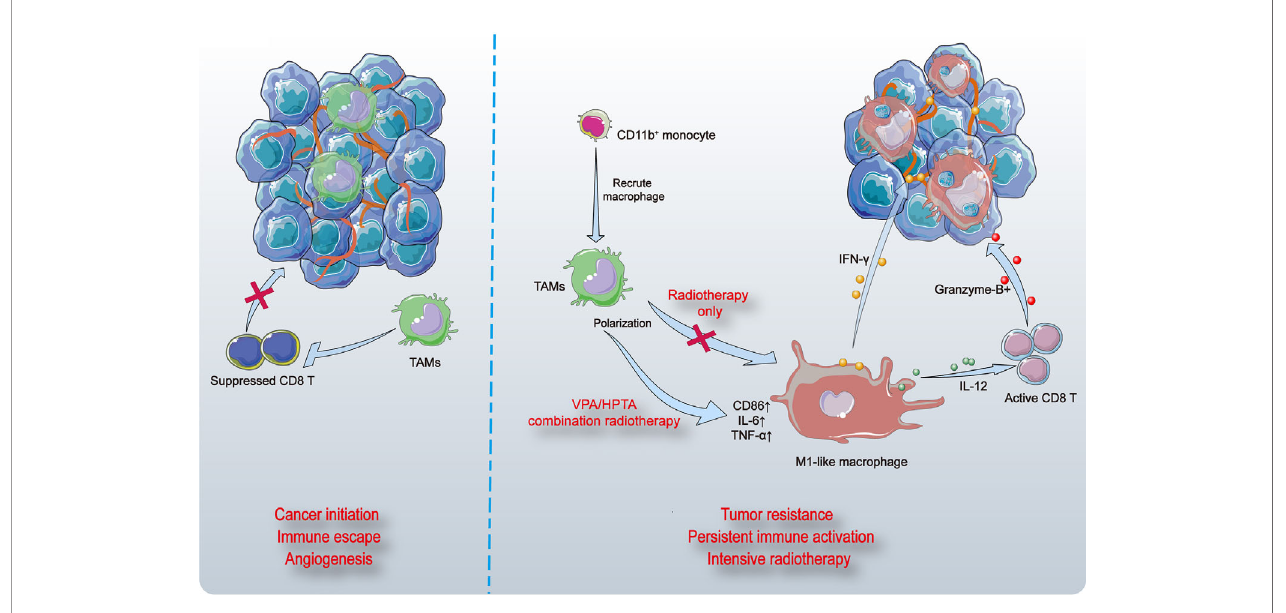
FIGURE 8 | The model of VPA/HPTA to enhance and prolong the radiotherapy effect by activating and maintaining anti-tumor immune response. Breast tumors in rats induced by DMBA contain abundant vasculature and pro-tumor macrophages (TAMs) that suppress the function of CD8+ T cells (left). Myeloid-derived cells are recruited to tumor sites, differentiate into macrophages, and further polarize toward M1 phenotype, thus promote in fl ammatory response. CD8+ T cells are activated, granzyme-B is secreted possibly through the IL-12 pathway, thereby killing tumors. The vasculature of tumors becomes sparse, possibly due to stimulation by IFN- g . At the same time, the combination treatment not only effectively improve the effect of radiotherapy during the immediate exposure, the concurrent therapy also delay the growth of tumors and prolong the anti-tumor effect by continuously activating the immune response to compensate for recurrence after